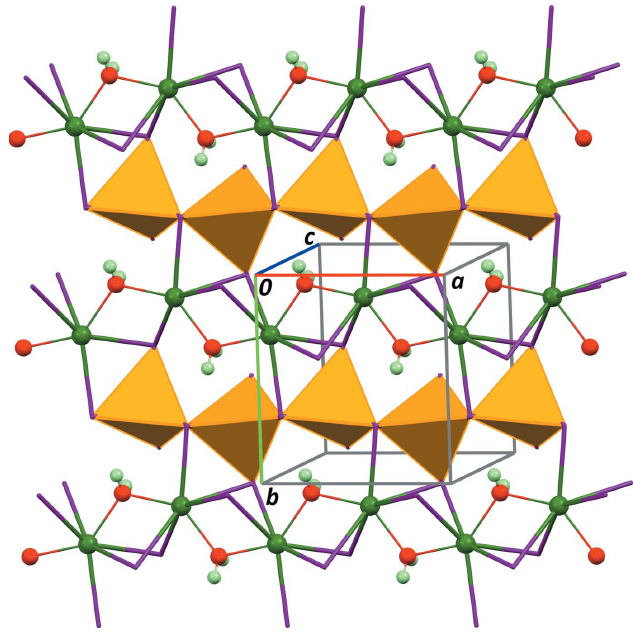
Figure 1 Part of the crystal structure of the title compound. Colour code: orange = [HgI 4 ] tetrahedra, purple = I, green = K, red = O, pale green =